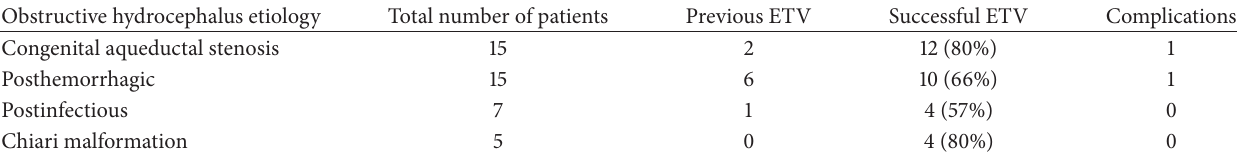
Table 1: Results according to obstructive hydrocephalus